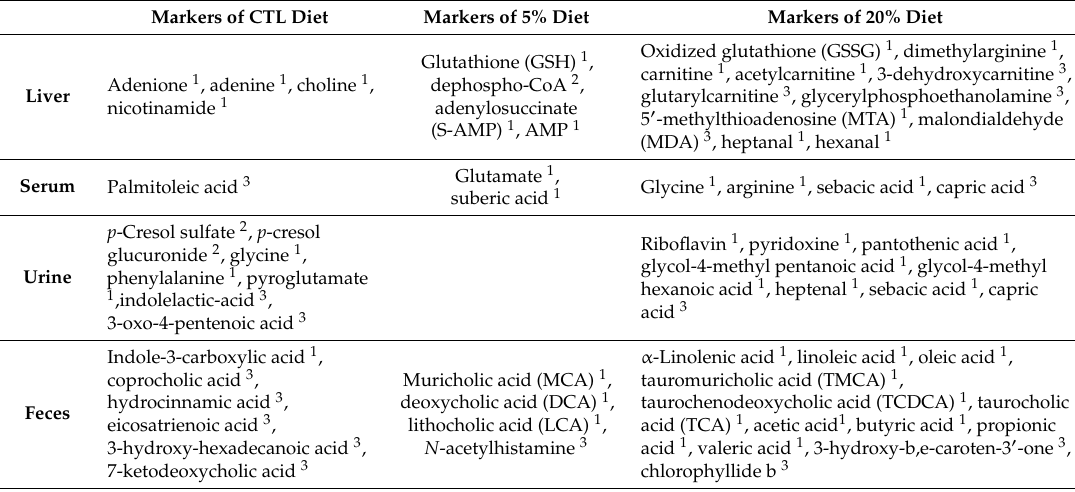
Table 1. E ff ects of Scenedesmus feeding on hepatic, serum, urinary, and fecal metabolomes *.